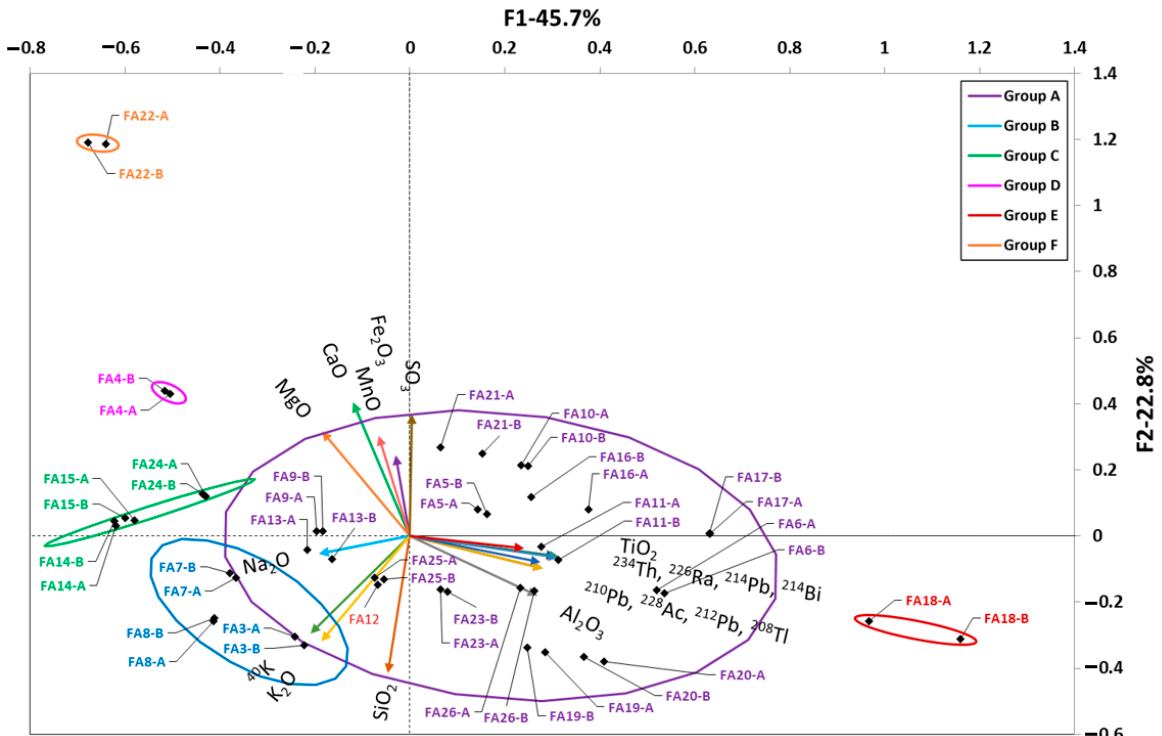
Figure 4. HJ–Biplot for the analyzed FA. The variables studied were CaO, SO 3 , SiO 2 , MnO, MgO, K 2 O, Na 2 O, TiO 2 , Fe 2 O 3 , Al 2 O 3 , radionuclides of the uranium and thorium series, and 40 K, represented as a vector. The 6 groups obtained are represented by their confidence ellipses and show high variability as they are distributed in the 4 quadrants. FA22 can be considered an outlier with respect to the other 5 sets of